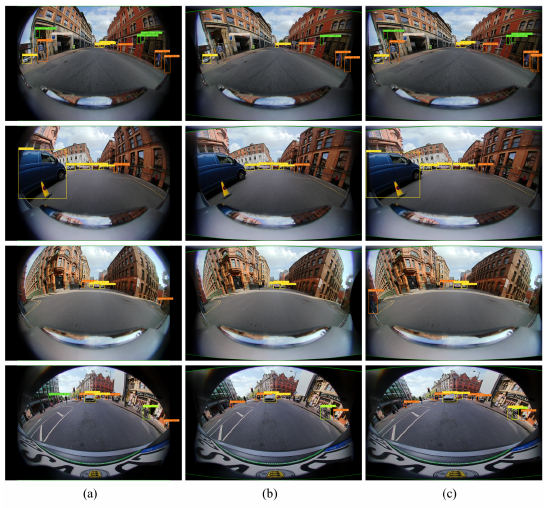
Figure 13. Detection results: ( a ) Synthetic fisheye image; ( b ) Spherical-projected image; ( c ) Expanded- Spherical-Projected image.